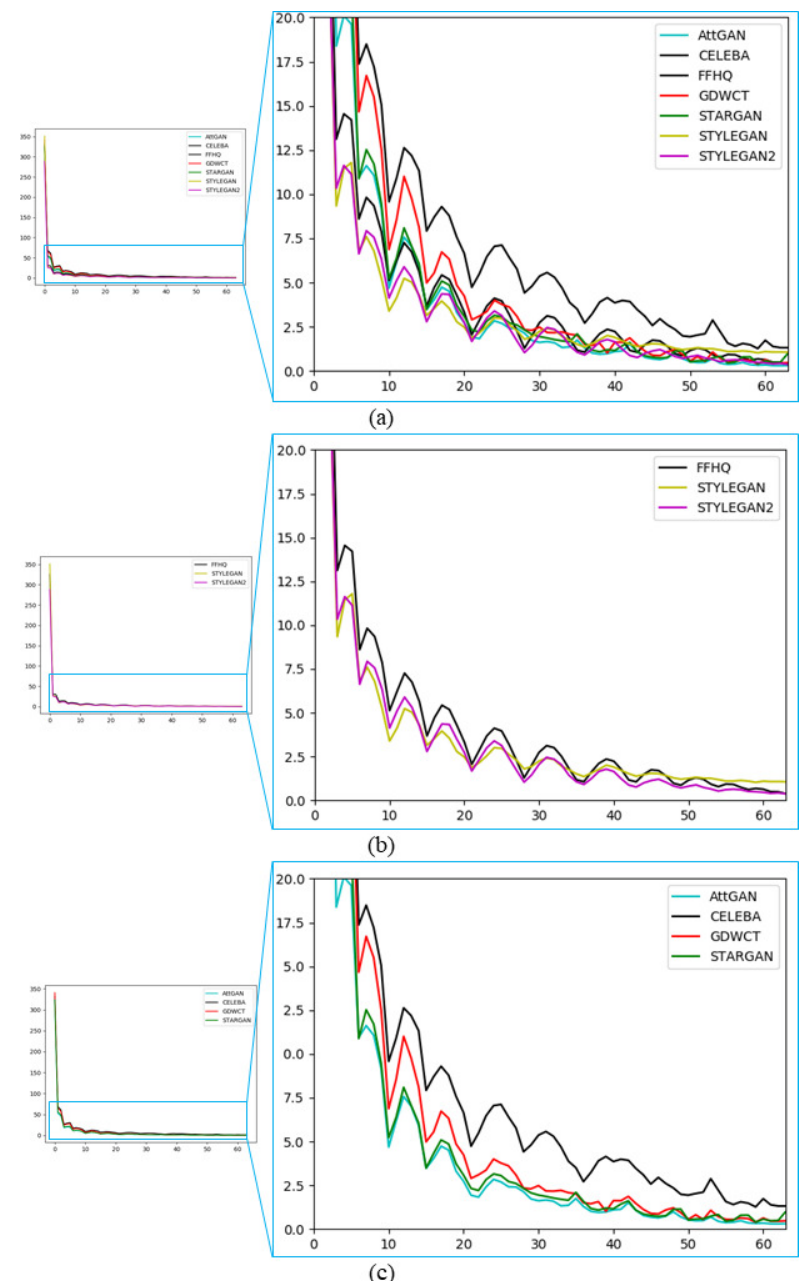
Figure 4. Plot of β statistics of each involved dataset. The average β value for each i -th coefficient is reported. ( a ) Shows the average β trend of all datasets (real and deepfake); ( b ) Shows the average β trend of StyleGAN and StyleGAN2 compared to the real image dataset used for their creation (FFHQ); ( c ) Shows the average β trend of StarGAN, AttGAN and GDWCT compared to the real image dataset used for their creation (CelebA). For each plot, the abscissa axis represents the 64 coefficients of the 8 × 8 block, while the ordinate axis are the respective inferred β values (in our case the average of the β values computed for all images of the respective